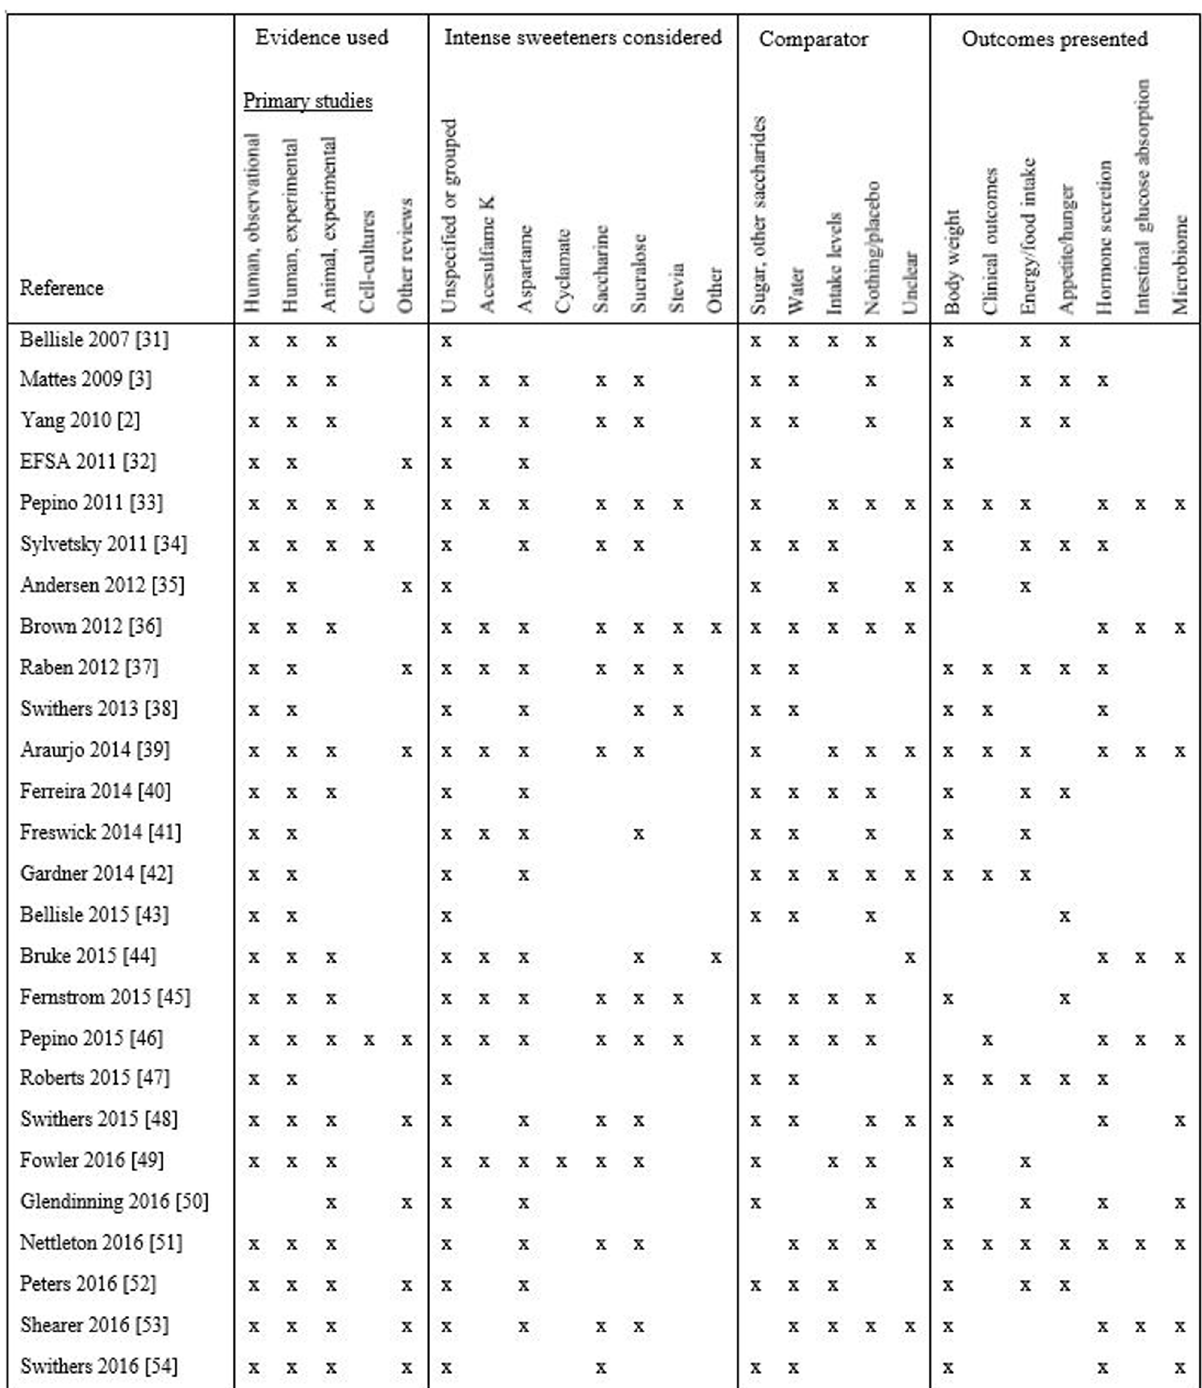
Fig 2. Features of included reviews without description of study selection, all narrative analyses.